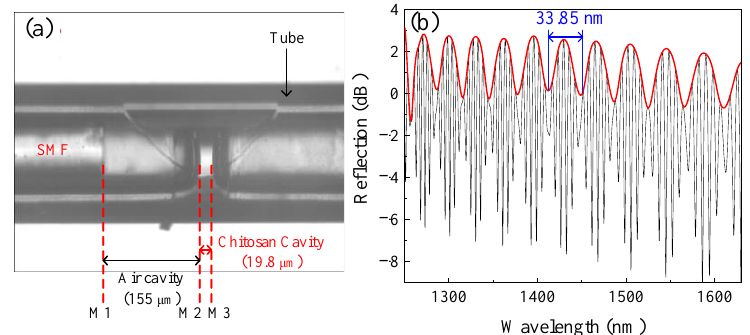
Figure 7. Microscopic image of the sensor and corresponding spectrum. ( a ) Microscopic image of the sensor; ( b ) spectrum of the sensor.